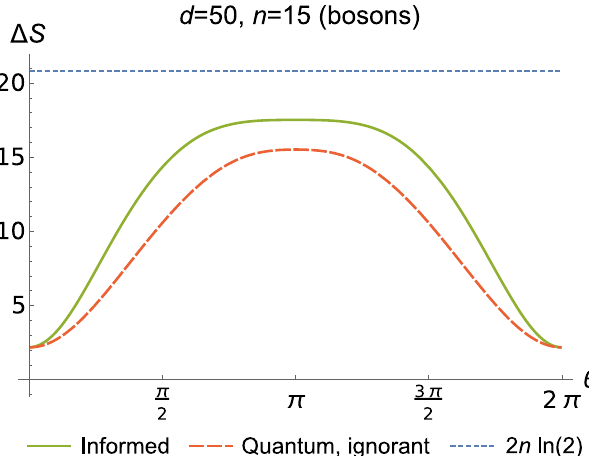
Fig. 4 Results for partially distinguishable spins. Plots of Δ S info , Δ S igno as a function of orthogonality of the spin states as determined by θ in (32). The fi gure is for a bosonic system with initial numbers of particles on either side of the box n = m = 15, and d = 50 cells. For comparison, the fi gure also displays the classical change in entropy, 2 n ln ð 2 Þ . Here, the greatest change in entropy occurs when the spin states are orthogonal at θ = π